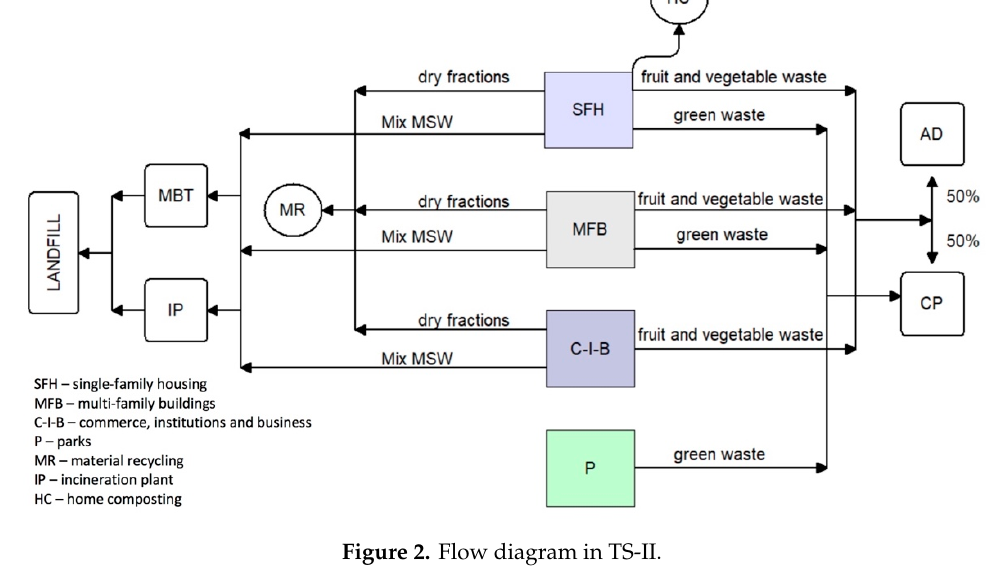
Figure 2. Flow diagram in TS-II.